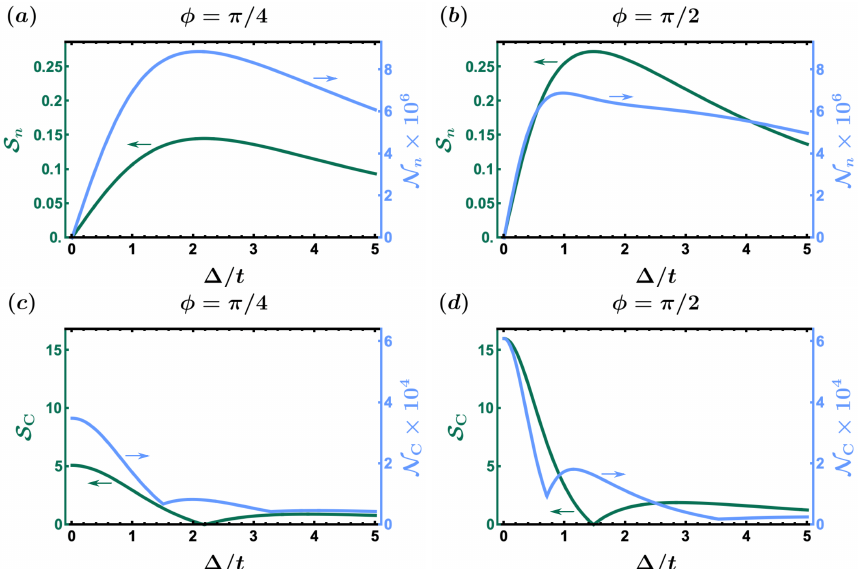
Figure 9: Effect of noise in the MZM-QD coupling. Signal (20) and noise (21) for the 2-MZM measurement of the average QD charge 〈 n / C QD capacitance C Σ ,D (c)-(d) as a function of detuning diff of φ . Here we assume that the system is in its ground state ( T = 0) and set | t | = t , | t | = 1.5 t , t = (cid:34) / 5 = 0.02 meV, C 1 2 C (cid:112) α ∼ 10 − 5 coupling noise t